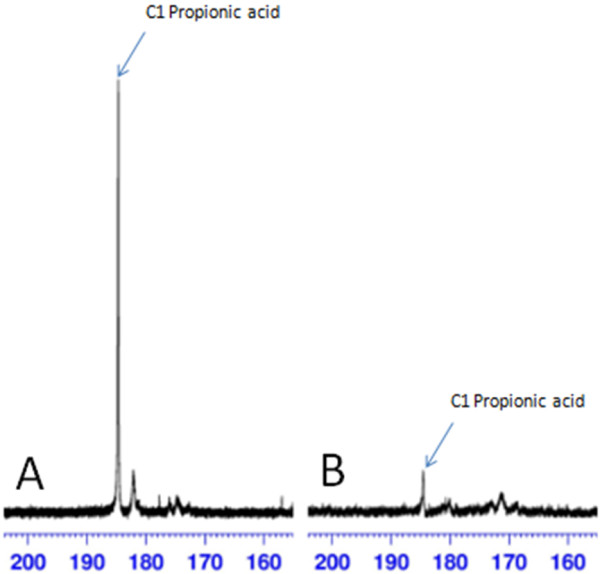
P. acidipropionici culture under CO2atmosphere.A, Culture under 13CO2 (labeled) and B, Culture with CO2 (unlabeled).